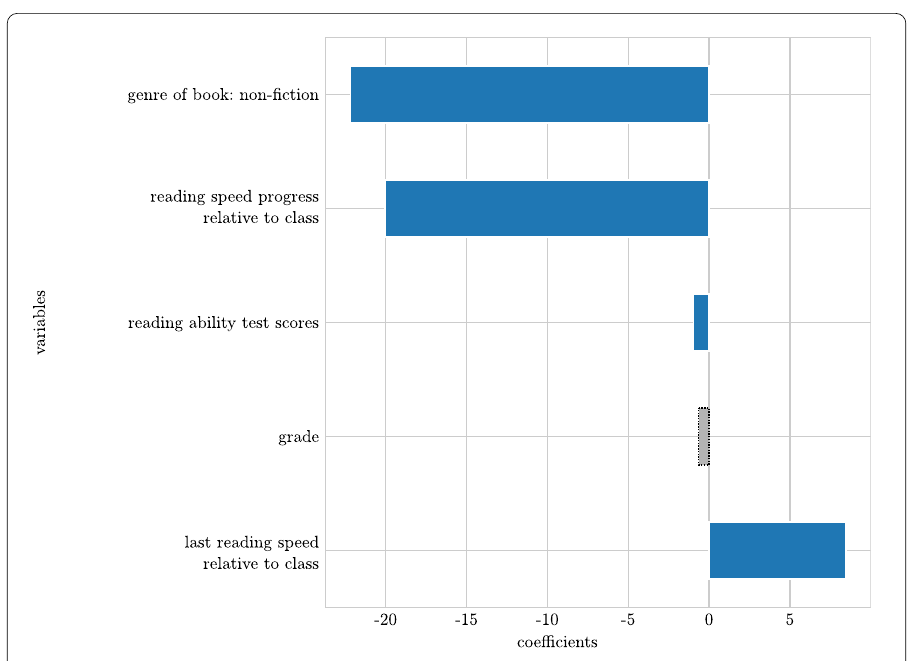
Figure 7 Standardized coefficients of ridge regression model with reading speed progress as outcome. Non-significant influences ( p < 0.05) are marked by grey bars with dotted borders